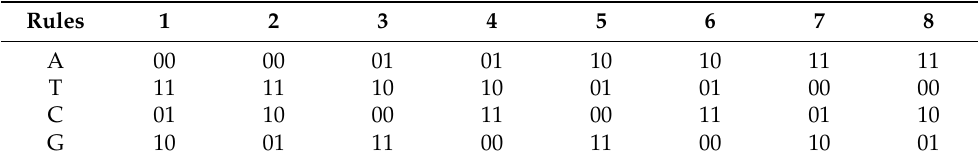
Algorithm 1. Foraging behavior Pseudo-code.